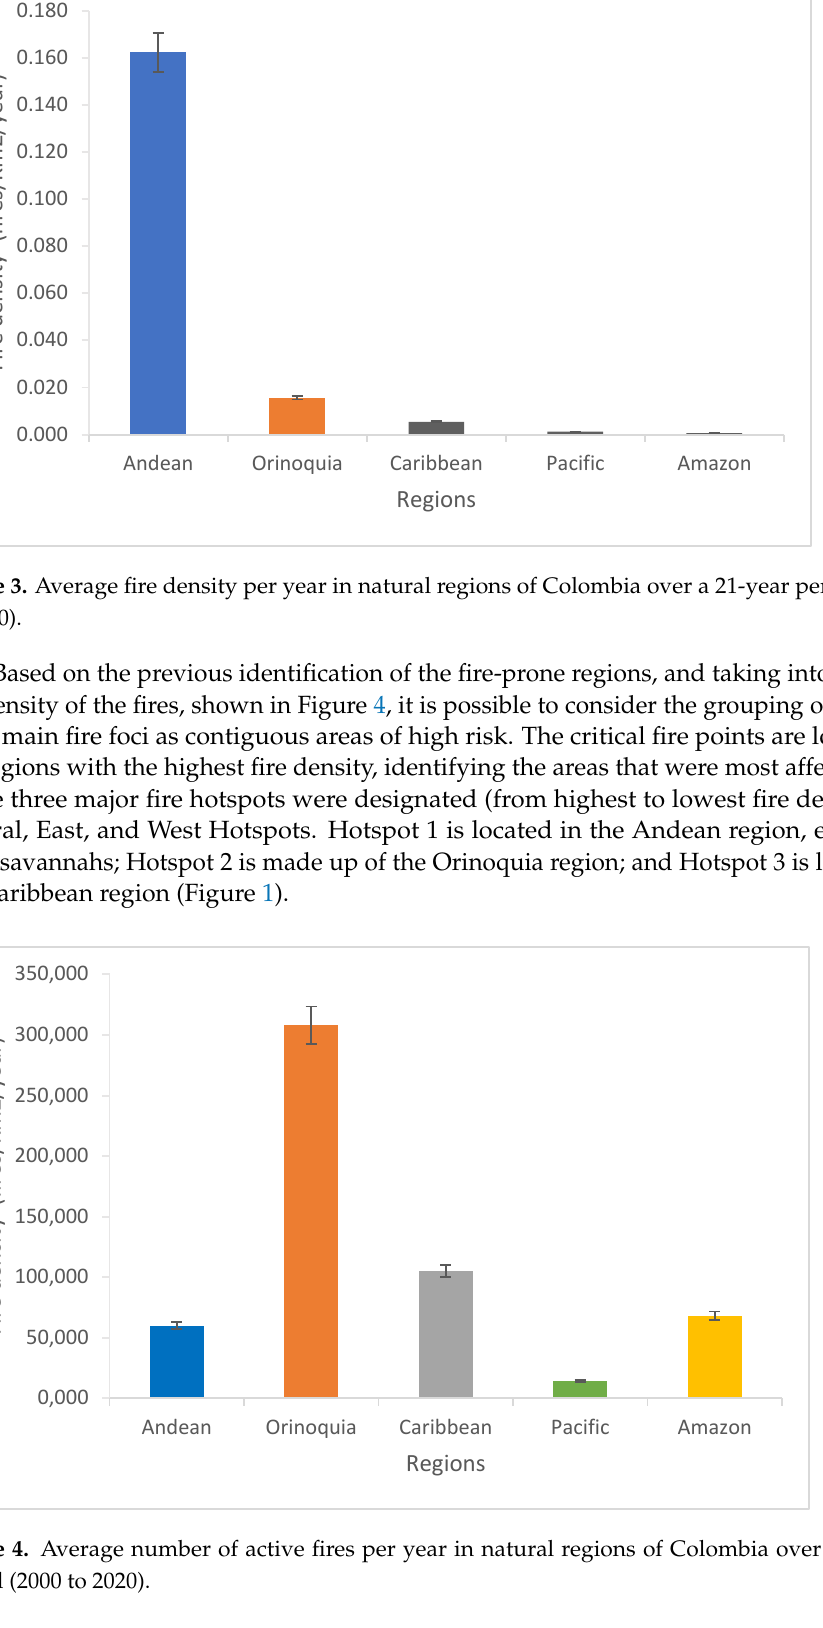
Figure 4. Average number of active fires per year in natural regions of Colombia over a 21-year period (2000 to 2020).